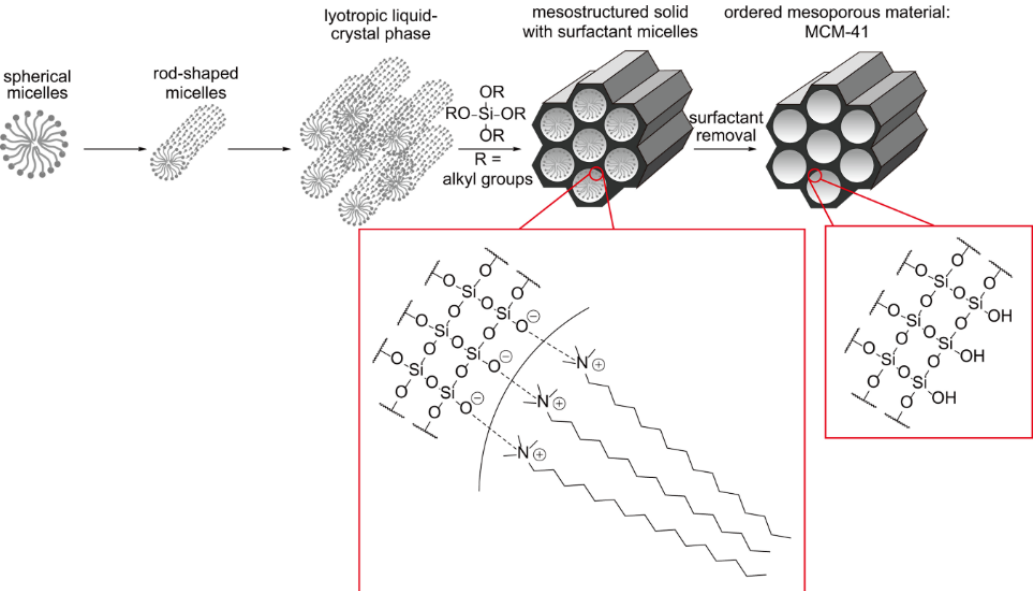
Figure 1. A schematic illustration of the synthesis of MSNs. Initially, surfactant micelles are formed which then self-assemble forming a lyotropic liquid-crystal phase. Condensation of the silica source around the surfactant template and subsequent surfactant template removal produces MCM-41. Here, tetraethyl orthosilicate (TEOS) is used as the silica source and cetyltrimethylammonium bromide (CTAB) as the surfactant template.